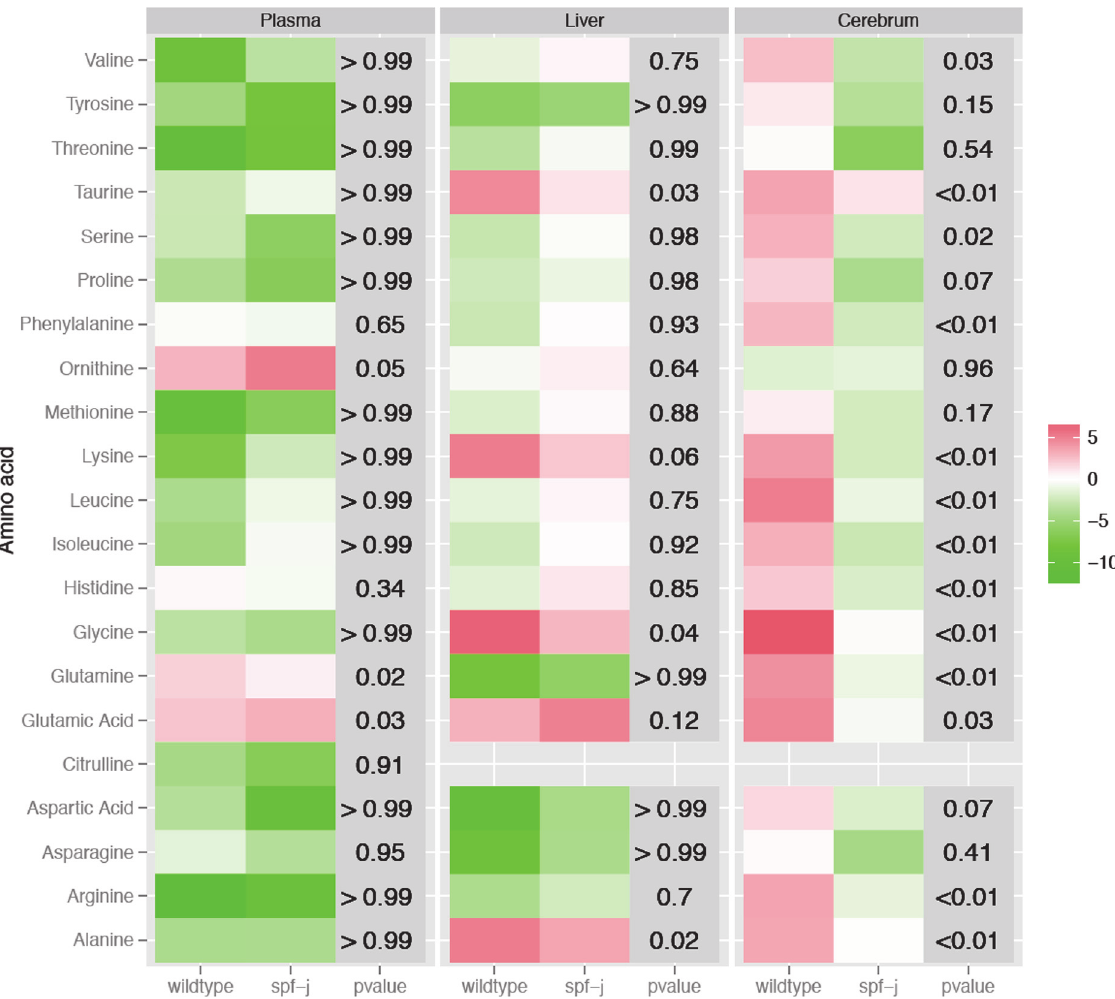
Figure 5. Changes in amino acids from baseline during immune challenge. Spf-J (N = 5) and WT (N = 5) received an intraperitoneal injection of poly I:C (100 μ g) once a day for 3 days. Tissues harvested and snap frozen and stored at − 80°C until use. Heat maps were constructed as described in Methods to represent the change in amino acid concentrations from baseline for plasma (left panel), liver (middle panel) and cerebrum (right panel). P-value < 0.05 was set as the threshold for significance.